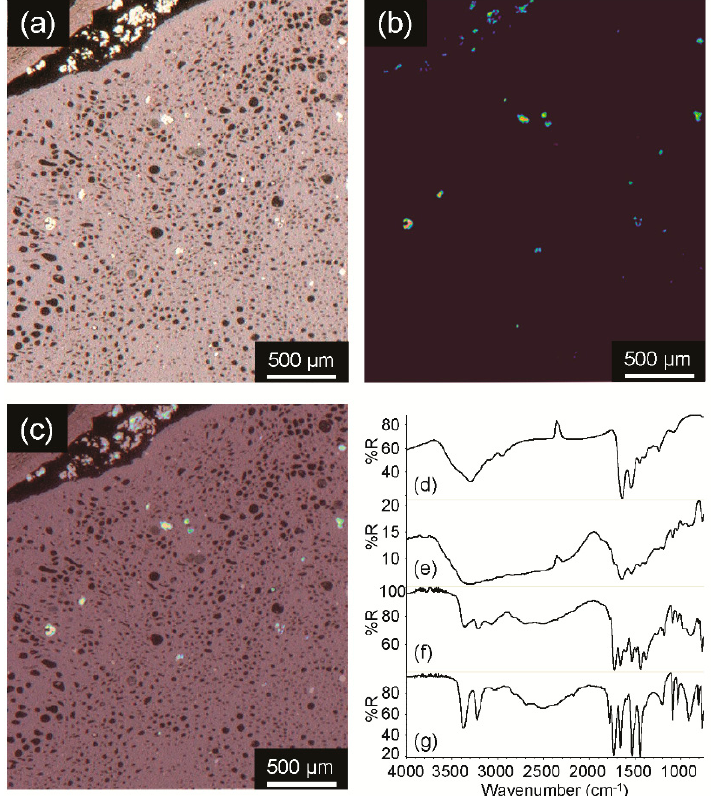
Figure 1. Visible image ( a ); R/A correlation image for melamine cyanurate ( b ); overlay image of (a) and (b), ( c ); representative R/A spectrum from a low correlation region ( d ); representative R/A spectrum from a high correlation region ( e ); ATR spectrum from a high correlation region ( f ); and ATR spectrum of a melamine cyanurate pure compound reference standard ( g ).